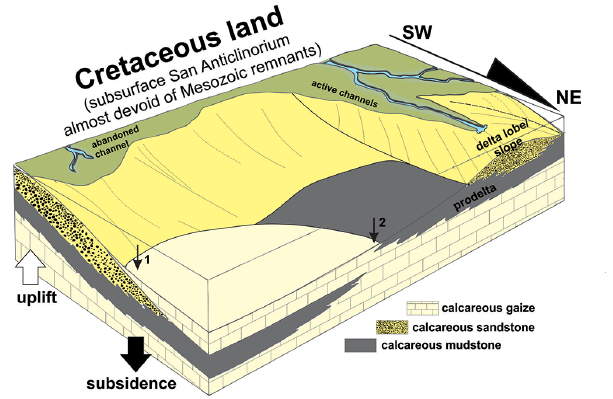
Figure 10. Block diagram illustrating the relationships between the subaerial (not available in the study area) and subaqueous deltaic environments of the Szozdy delta in relation to active and abun- dant distributary channels. Arrows 1 and 2 indicate two different situations, i.e., (1) a full tripartite cyclothem and (2) an incomplete cyclothem; compare to Fig. 5. Not to